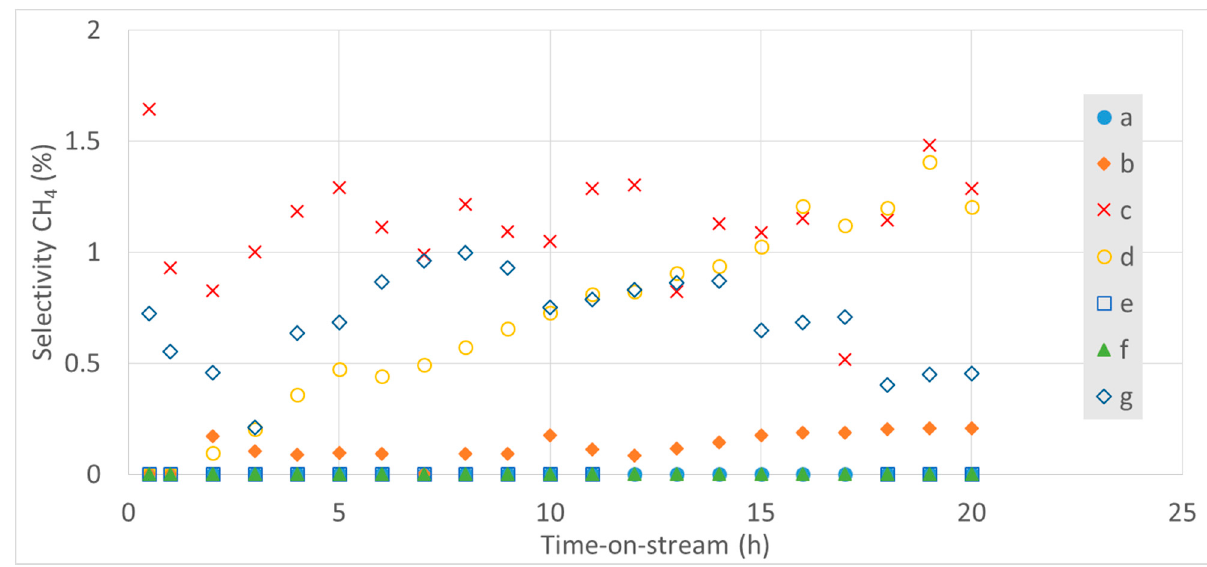
Figure 8. Selectivity to CH 4 at 650 ◦ C, feed 10 wt% glycerol in water. ( a ) La 0.3 Zr 0.7 NiO 3 ; ( b ) 10 wt% Ni/(0.3La 2 O 3 –0.7ZrO 2 ); ( c ) La 0.8 Sr 0.2 NiO 3 ; ( d ) CeNiO 3 ; ( e ) La 0.3 Ce 0.7 NiO 3 ; ( f ) 10 wt% Ni/(0.3La 2 O 3 –0.7CeO 2 ); ( g ) LaNiO 3 .